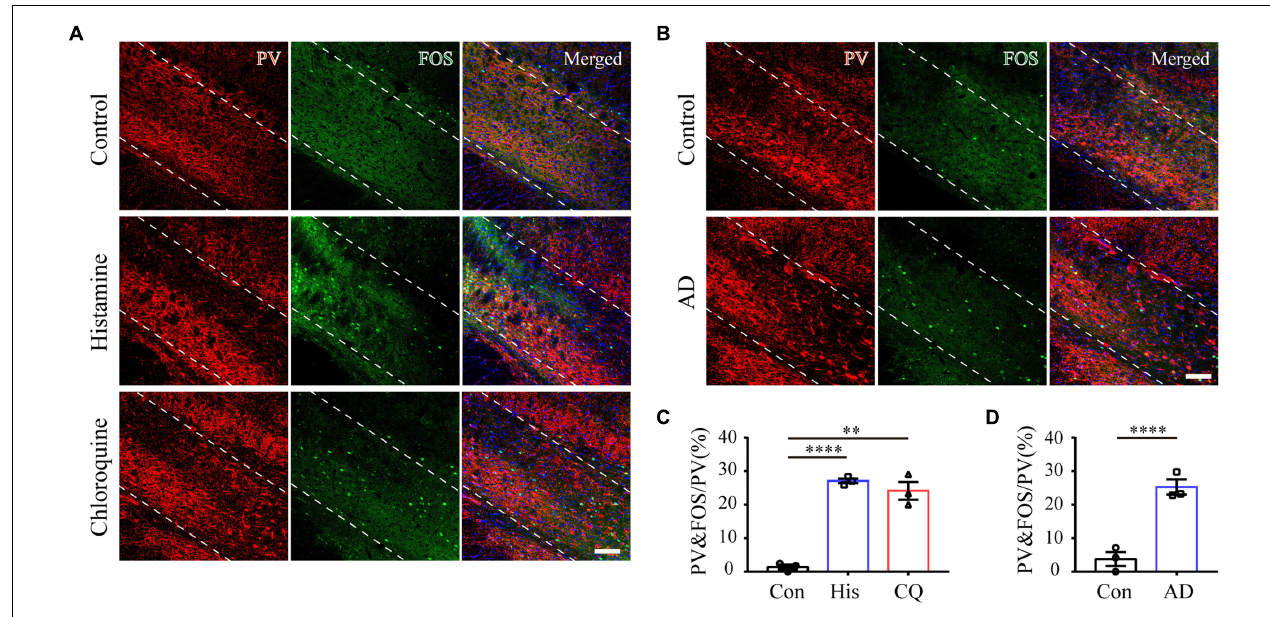
FIGURE 2 | Acute and chronic itch stimuli increase FOS expression in ZI PV neurons. (A–C) Representative images of FOS and PV staining in ZI after saline (the upper panel), histamine (the middle panel), and chloroquine (the lower panel) injection. (B) Representative images of FOS and PV staining in ZI in control (the upper panel) and AD (the lower panel) mice. Scale bar = 100 µ m. (C) Quantification of FOS-expressing neurons in response to saline, histamine, and chloroquine injections showed both histamine and chloroquine stimuli increased FOS expression in ZI PV neurons. n = 3 mice per group, three sections per mouse. One-way ANOVA with post hoc LSD test for multiple comparisons. F (2,6) = 73.642, P < 0.001. (D) Quantification of FOS-expressing neurons in control and AD mice showed chronic itch stimuli increased FOS expression in ZI PV neurons. n = 3 mice per group, three sections per mouse. Unpaired T -test. t = –7.03, P = 0.002. ∗∗∗∗ P < 0.0001, ∗∗ P <